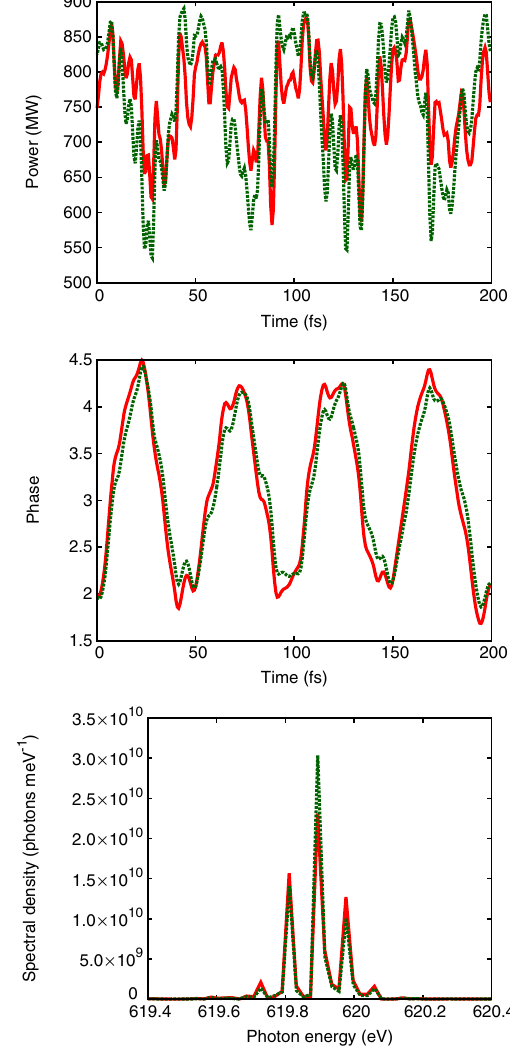
FIG. 9. Wigner plots obtained for the case of longitudinal profile 1 from the three beam lines: HGHG (top), EEHG (middle), and combined EEHG and HGHG (bottom). Red indicates a positive value, blue negative.